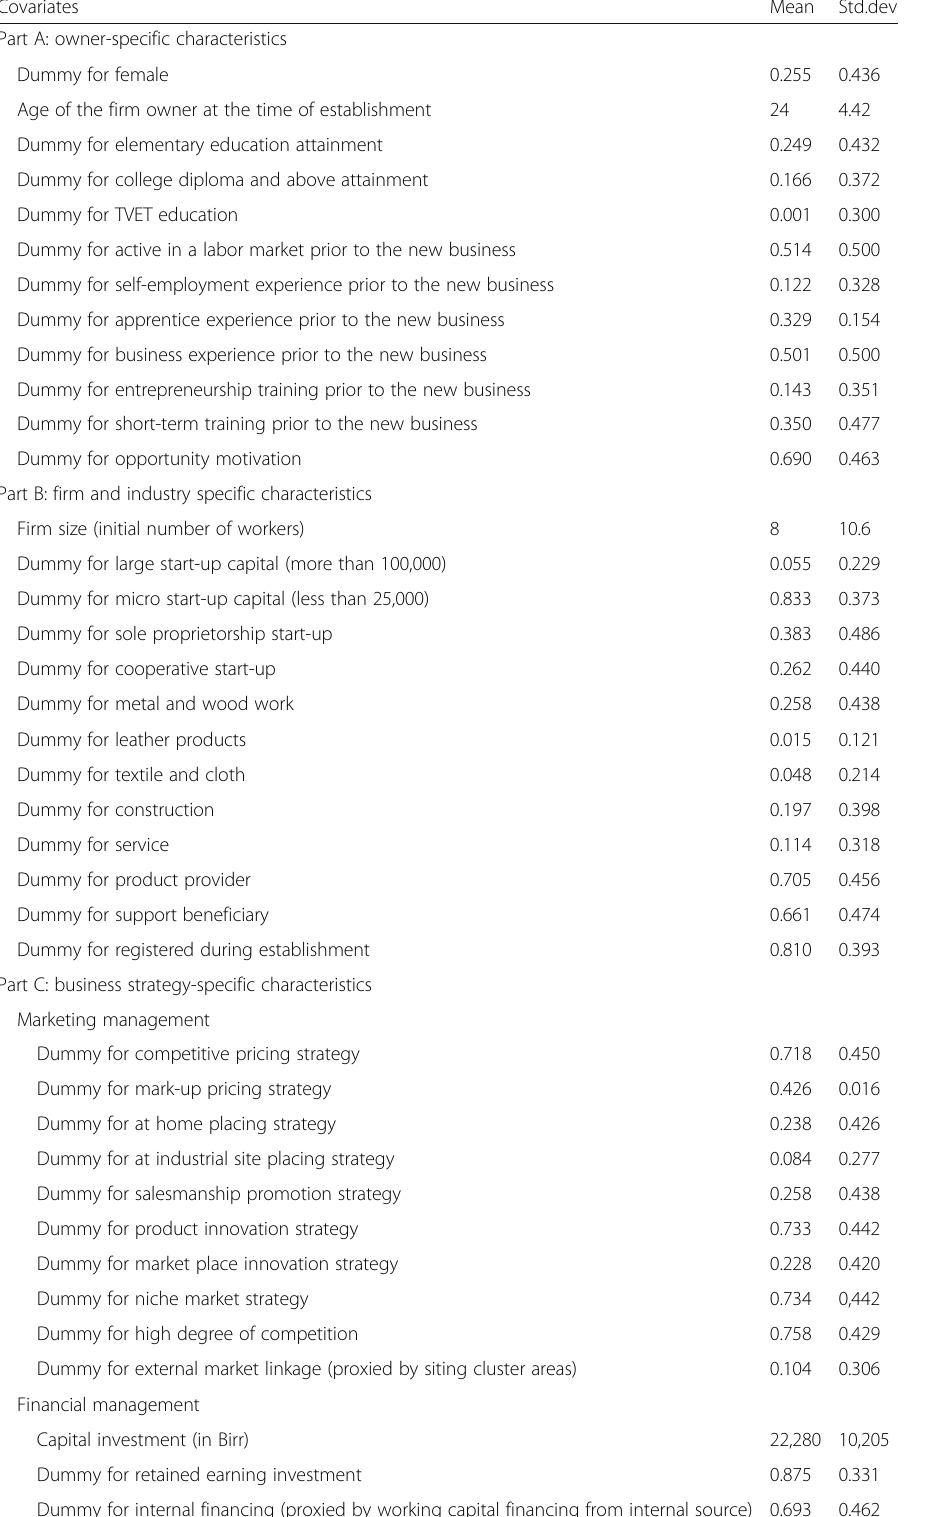
Table 1 Definition of variables and their corresponding mean and standard deviation value Covariates Mean